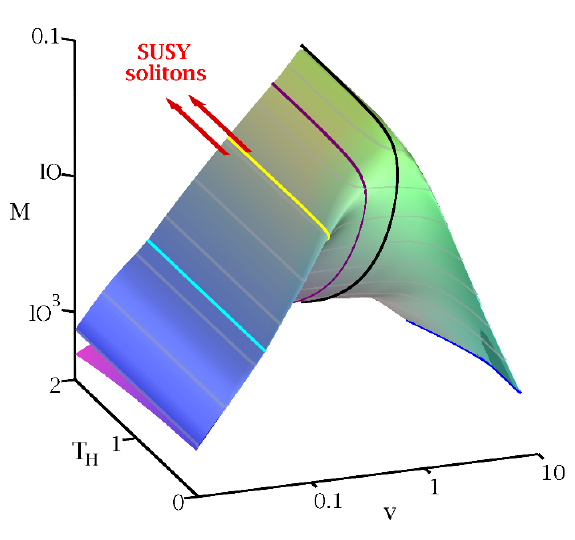
Figure 7. Mass M vs. squashing v vs temperature T H for a particular set of solutions. Their magnetization parameter c m , electric charge Q and angular momentum J are given functions of v such that no extremal black holes are obtained. Instead, the limit T H ! 1 describe susy solitons.